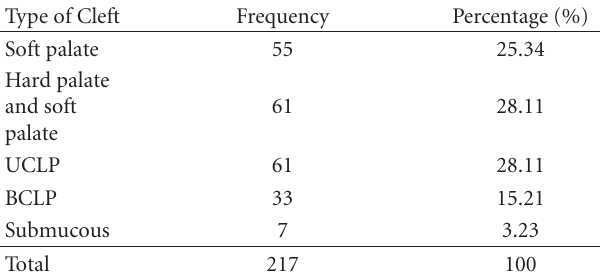
Table 4: Distribution of cleft types in the sample. UCLP: unilateral cleft lip and palate; BCLP: bilateral cleft lip and palate.